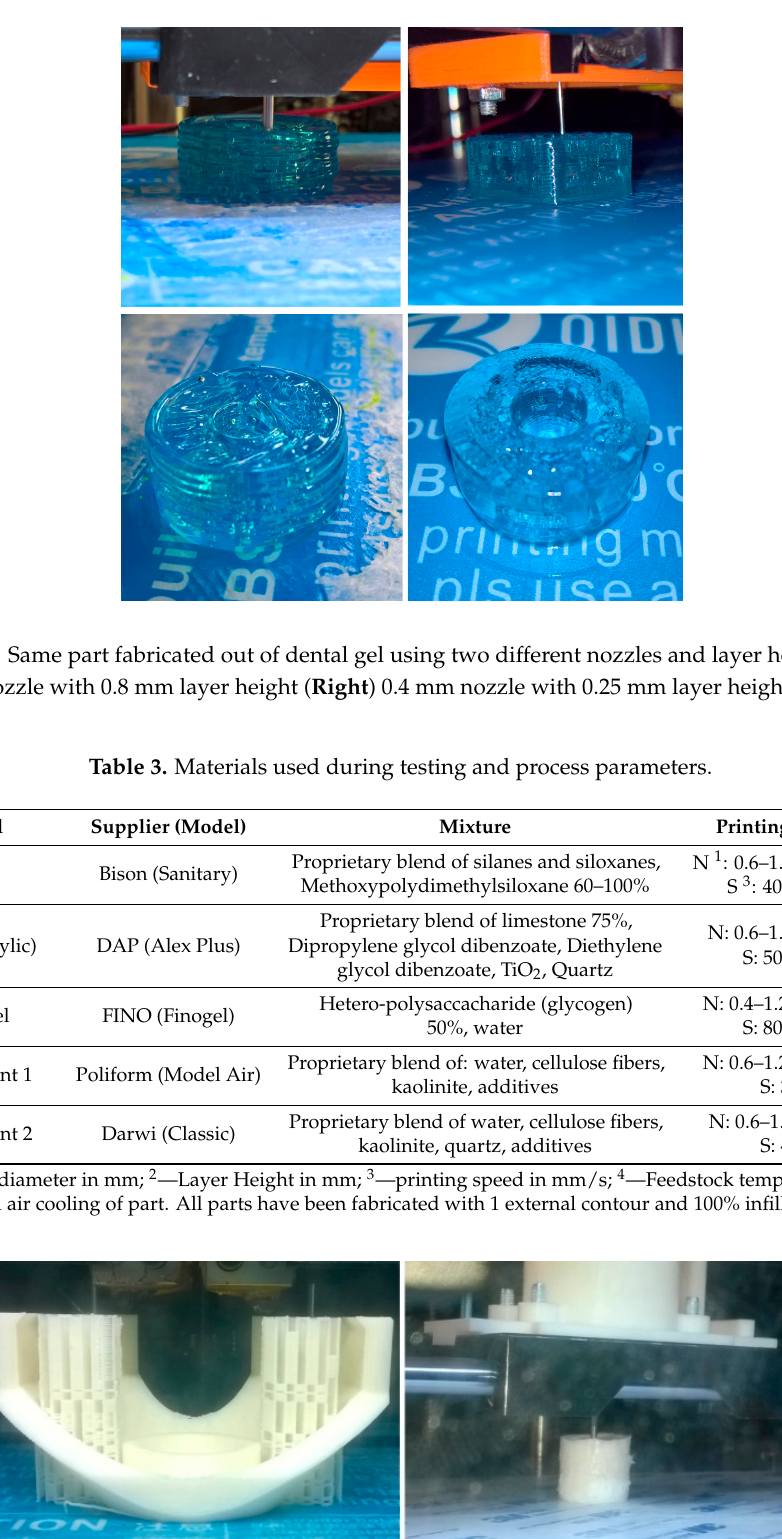
Figure 13. Fabricated parts using the proposed solution ( a ) Part fabricated using silicone ( b ) Part fabricated using white cement mixture ( c ) Part fabricated using commercial dental gel ( d ) Part fabricated using white cement mixture.